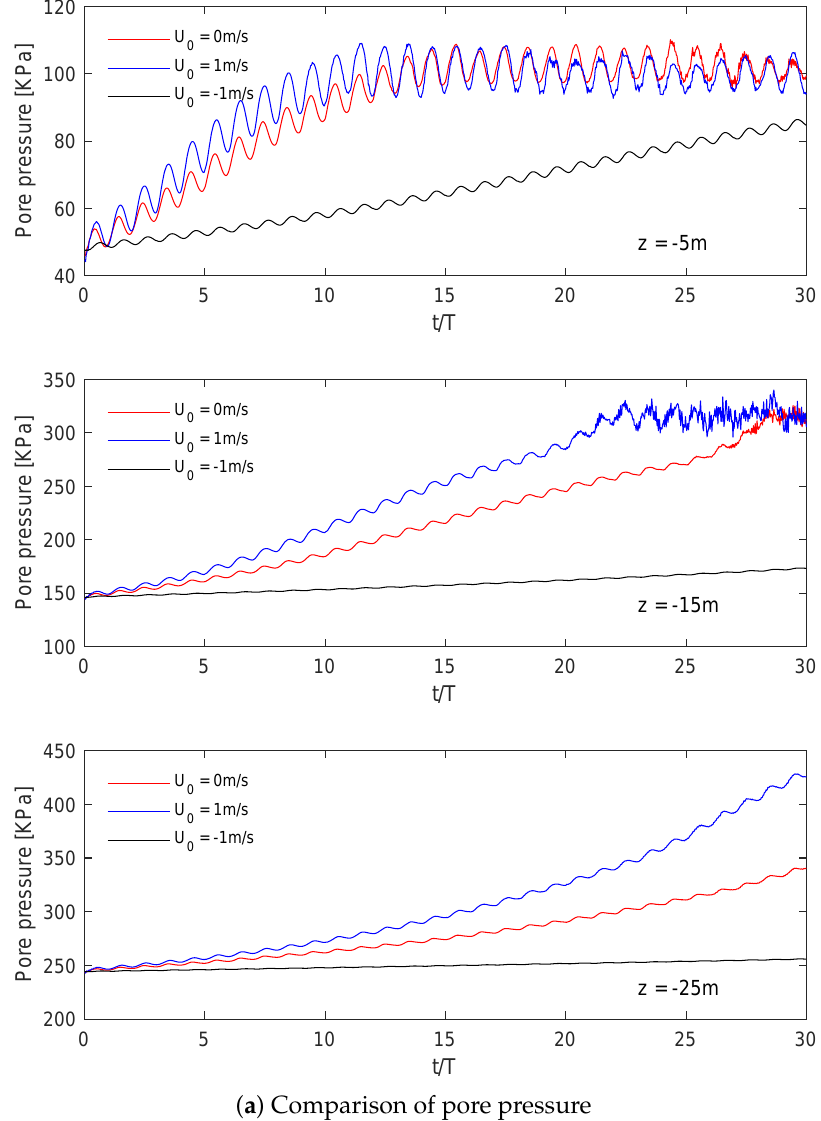
( a ) Comparison of pore pressure Figure 8. Cont